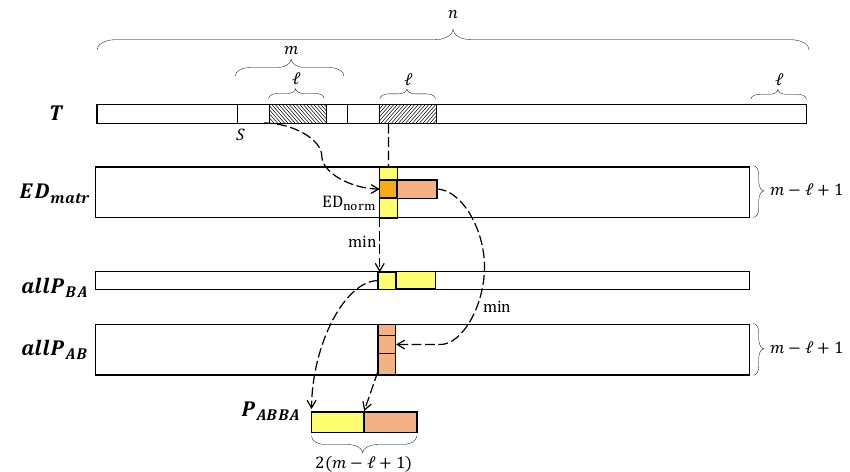
2( 𝑚𝑚 − ℓ + 1) Figure 1. Data structures of the PSF